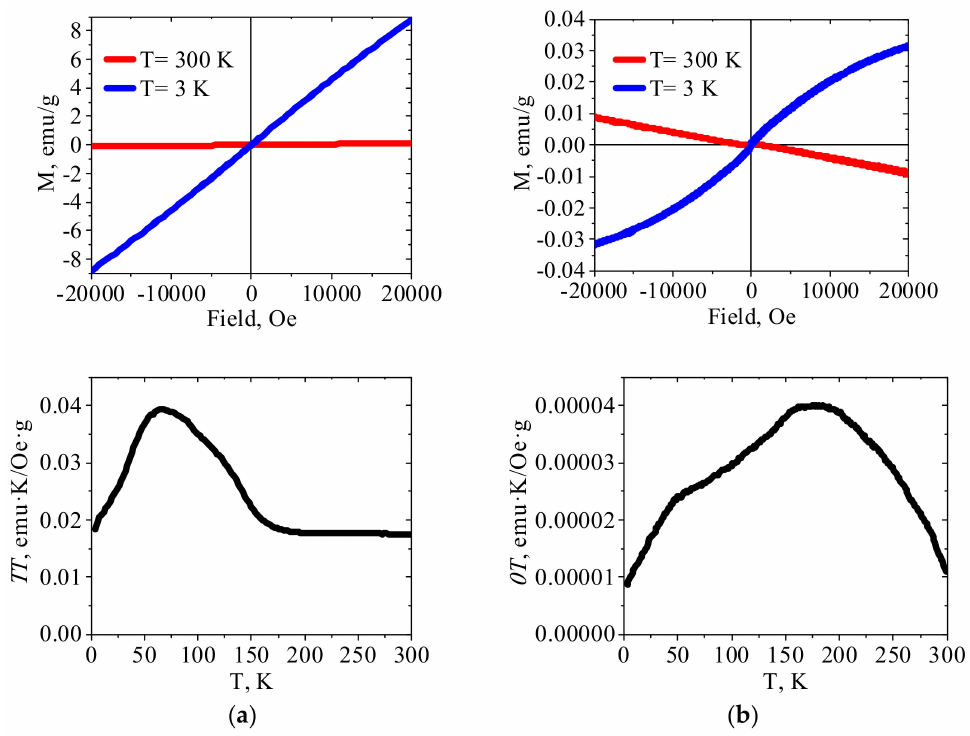
Figure 4. The magnetization curves and χ T temperature dependences for ( a ) crystalline Zn(II)HCF(III) and ( b ) PEI–Zn(II)HCF(III)